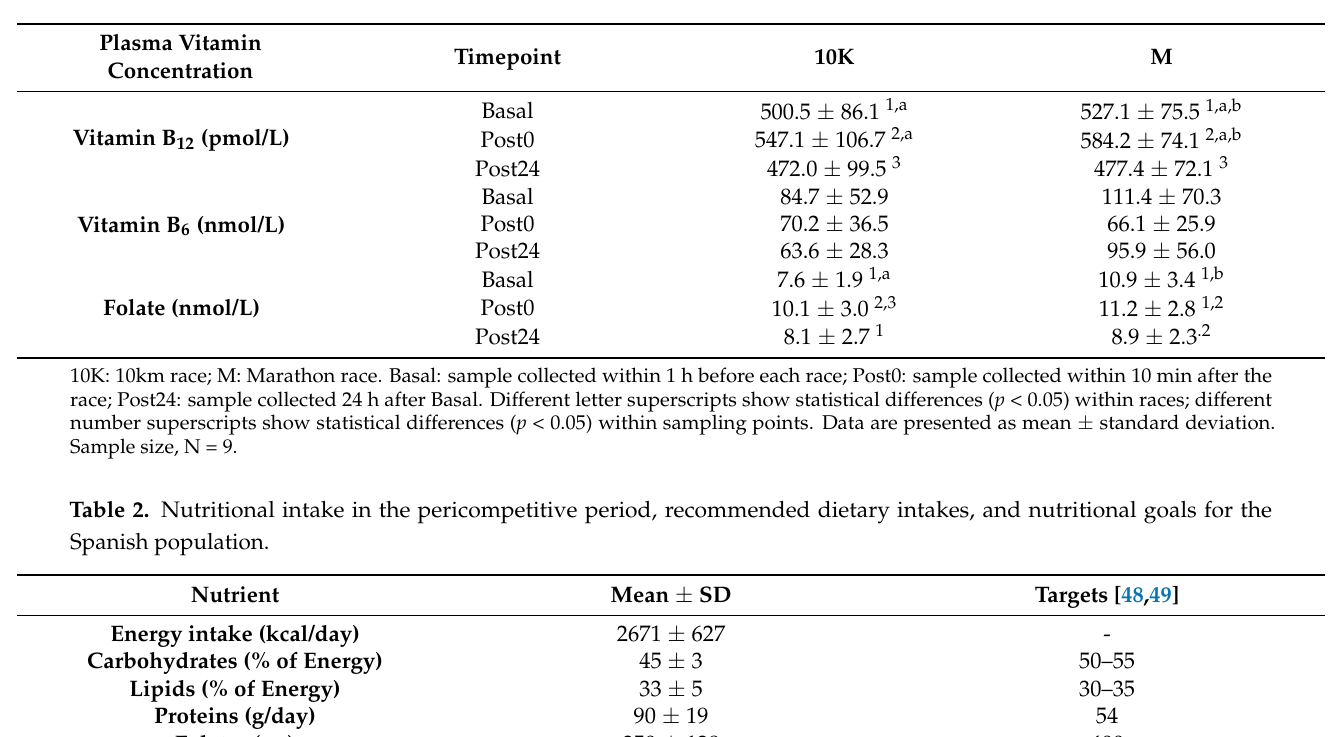
Table 1. Plasma levels of the main vitamins involved in homocysteine metabolism in response to different doses of acute exercise.